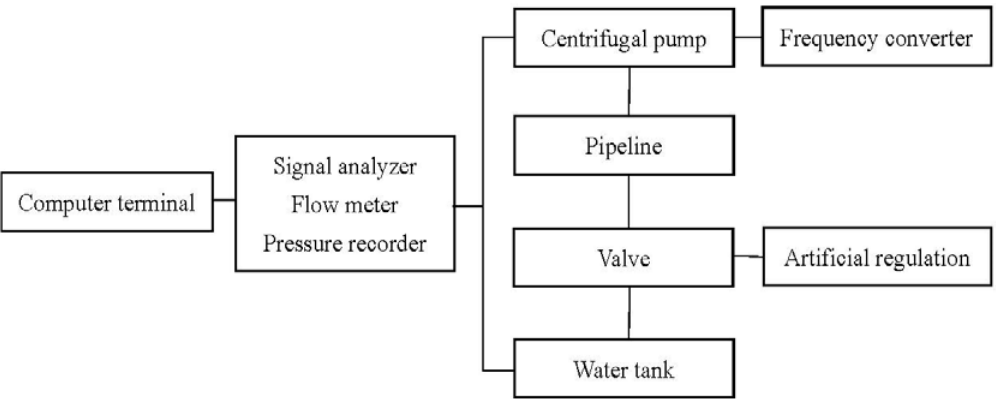
Figure 3. Structure diagram of measurement system.